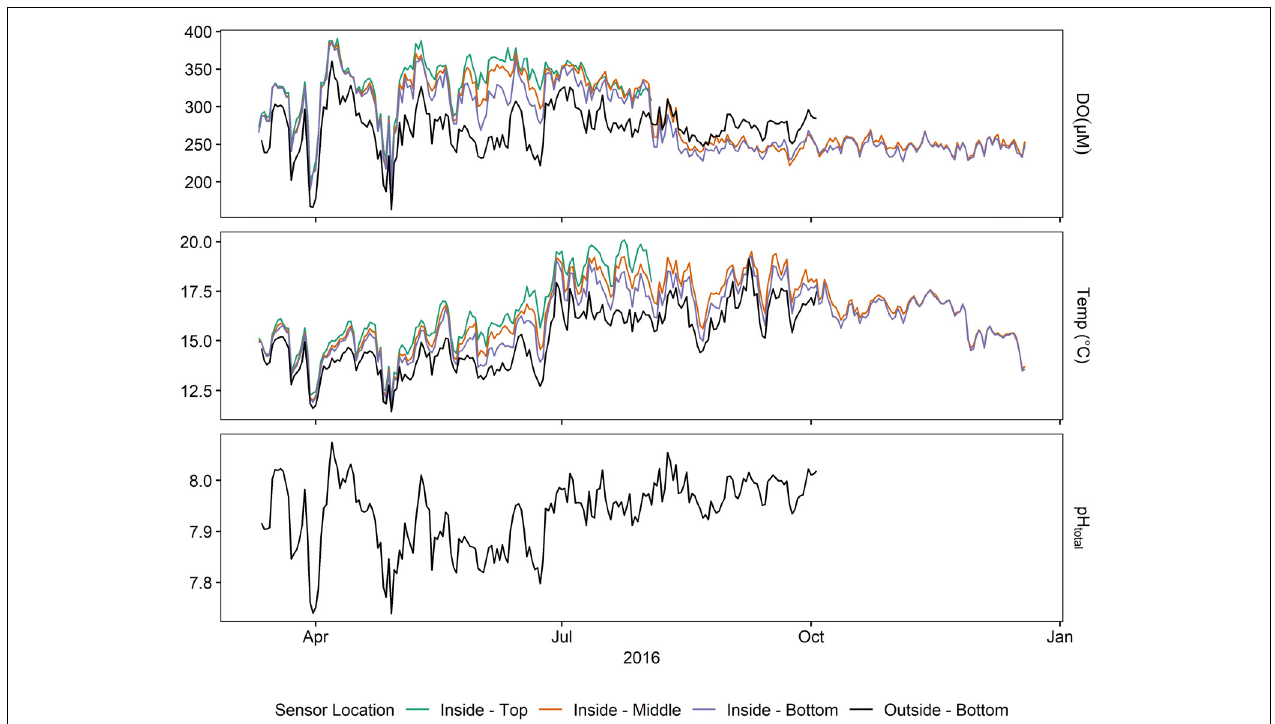
FIGURE 5 | Daily averages of oxygen, pH, and temperature at various sensors for Deployment 3 (March – December 2016).